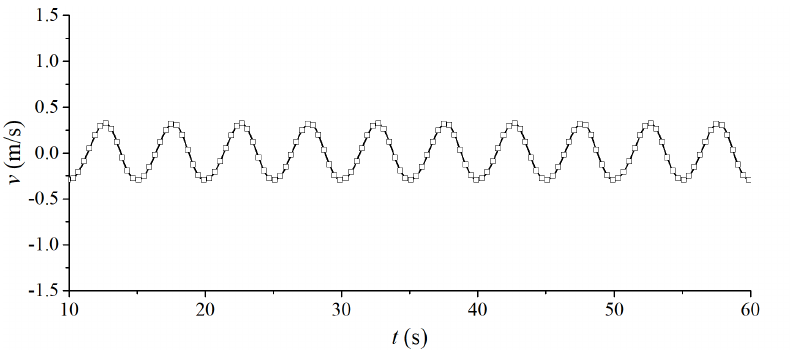
Figure 15. Velocity time histories of the floater when linear damping coefficient C is 70,000 N/(m/s).